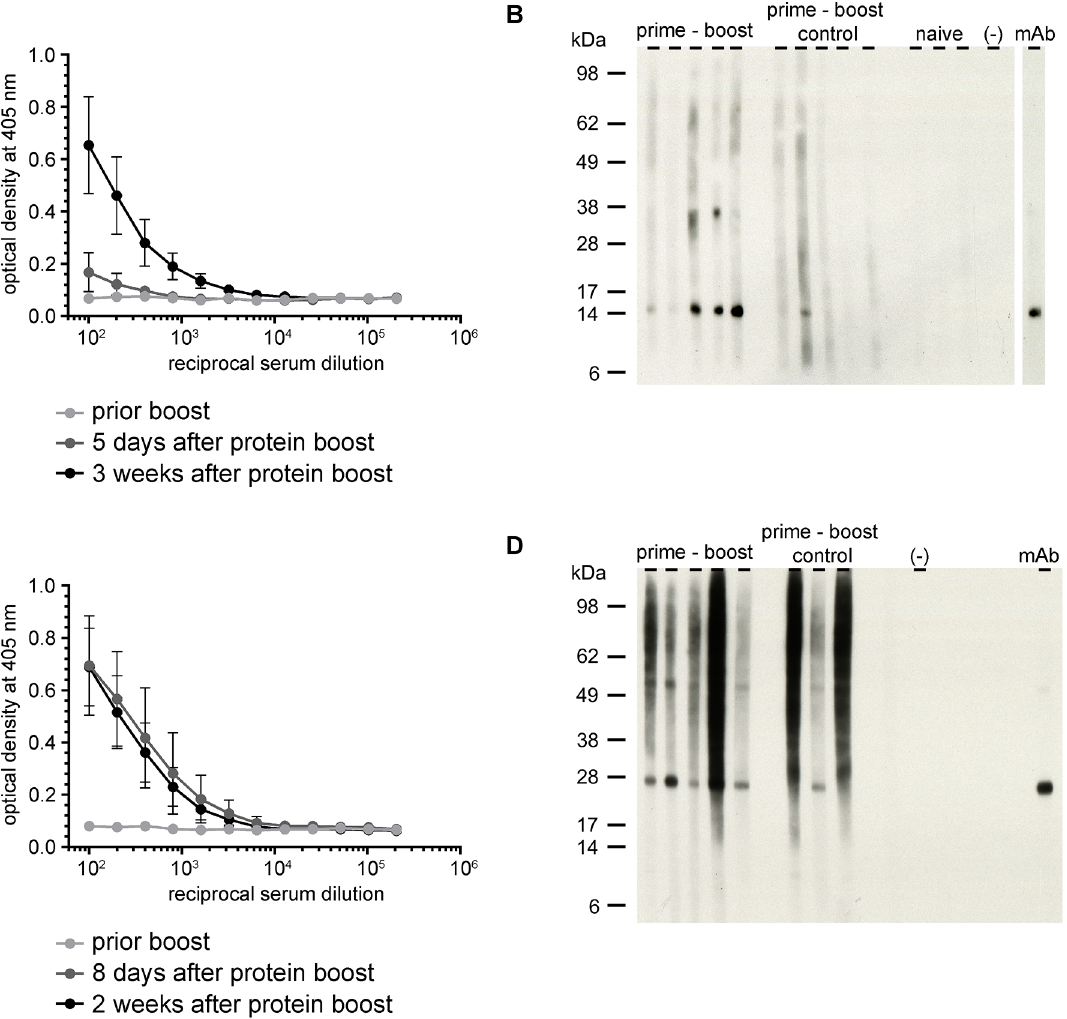
Fig 3. Induction of antigen-specific antibodies by a short prime-boost immunization protocol. Female BALB/c mice (n = 5) were immunized once with VSV * Δ G(MUL2232) or VSV * Δ G(MUL3720) and boosted with rMUL2232 or rMUL3720 three weeks later. Control animals (n = 5 and n = 3) were immunized with empty replicon prior to recombinant protein boost three weeks later. (A) Analysis of serially diluted immune sera by ELISA on immobilized rMUL2232. Mean values (dot) ± standard deviations are shown. (B) Western blotting analysis on M . ulcerans lysate using the indicated immune sera taken three weeks after protein boost. (C) Analysis of serially diluted immune sera by ELISA on immobilized rMUL3720. Mean values (dot) ± standard deviation are shown. (D) Western blotting analysis on M . ulcerans lysate using the indicated immune sera taken two weeks after protein boost.